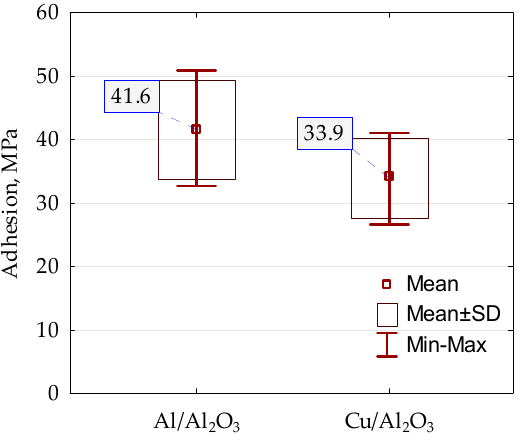
Figure 3. Cross-sectional microstructure of cold-sprayed MMCs on AISI 304 substrate: ( a ) Al/Al 2 O 3 ( b ) Cu/Al 2 O 3 . SEM-EDS chemical analysis in spots: 1—Al 94.7%, O 5.3%; 2—Al 56.4%, O 43.6%; 3—Cu 100%, 4—Al 66.6%, O 33.4%; (wt.%).